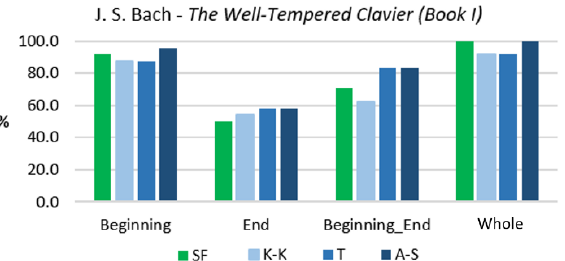
Figure 11. The key-finding efficacies obtained for the preludes of J. S. Bach, from The Well-Tempered Clavier collection (Book I); the samples represented using the aggregate durations of individual pitch-classes.